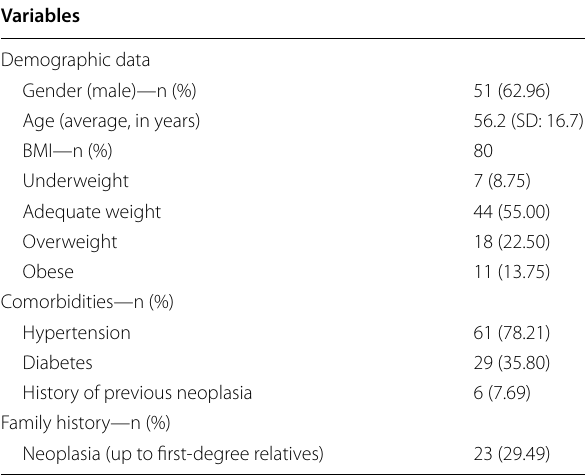
Table 1 Descriptive analysis of demographic data and comorbidities of the sample